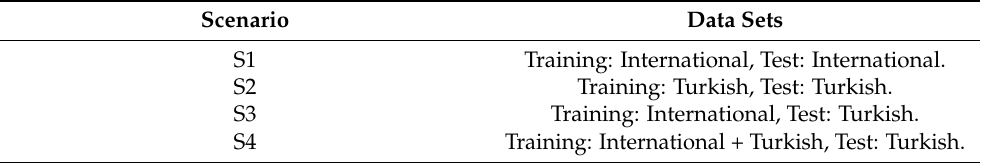
Table 3. Different data partitioning scenarios used in the study to train, test, and validate PC NN -PTFs. Scenario Data